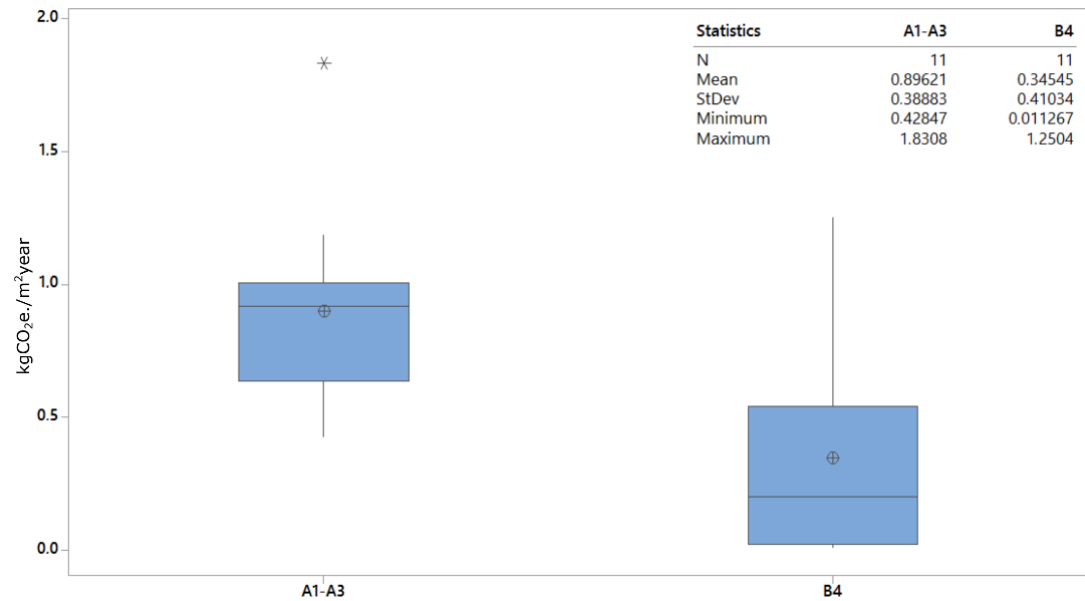
Figure 4. The distribution of embodied emissions per floor area and a lifetime of 60 years for the outer walls of the 11 buildings (kgCO 2 e./m 2 year).